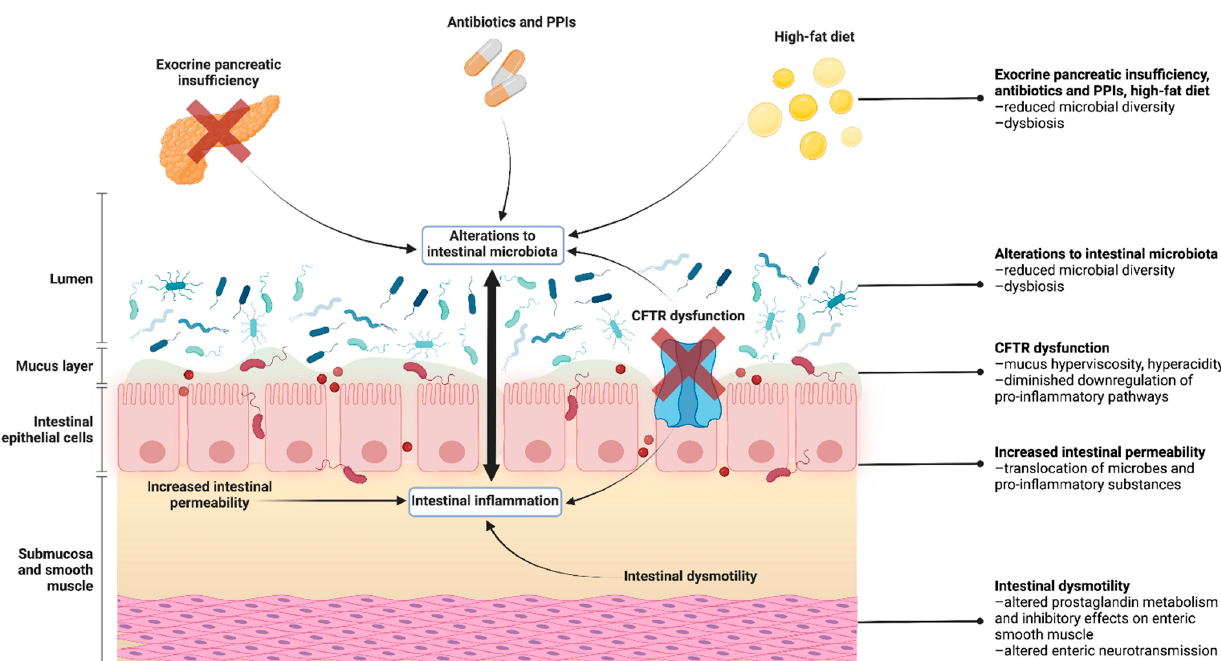
Figure 1. Factors contributing to the cystic fibrosis intestine. The pathogenesis of CF intestinal inflammation and alterations to the intestinal microbiota is multifactorial and complex. A number of intrinsic and iatrogenic mechanisms have been proposed, and it is likely a combination of these mechanisms that culminate in the CF intestine. (This figure was created with BioRender.com.).